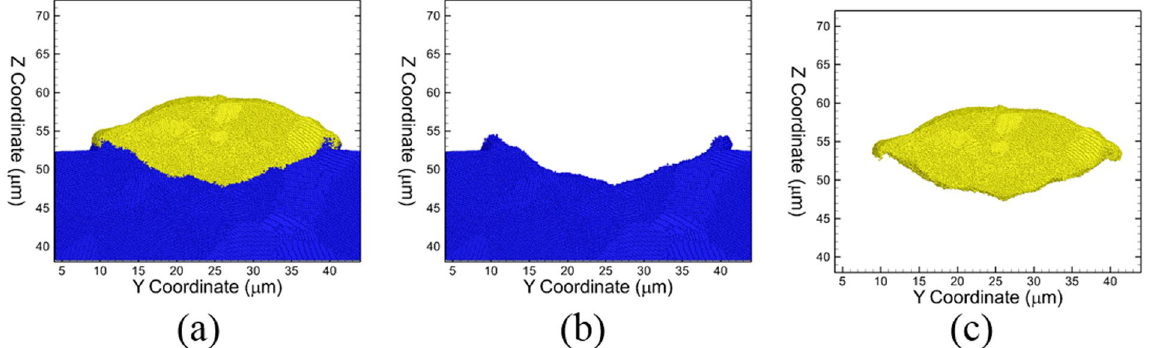
Figure 5. Snapshots indicating ( a ) the splat morphology of the Al particle at a time of t = 12 ns, ( b ) substrate displacement that initiated “jetting” and ( c ) particle morphology. The substrate R-atoms are colored blue and the particle R-atoms are colored